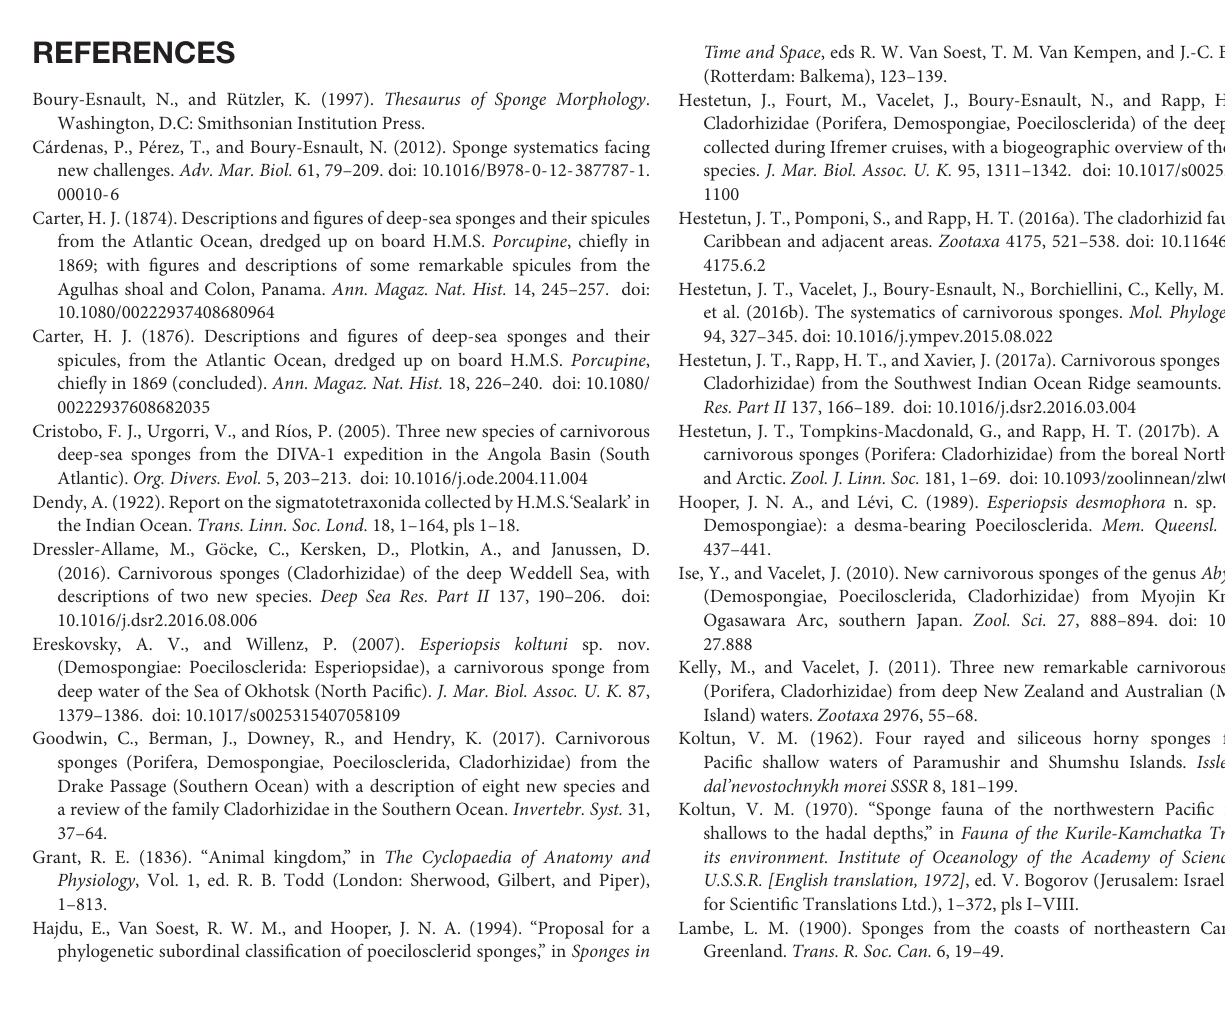
TABLE S1 | List of sequences used for the phylogenetic